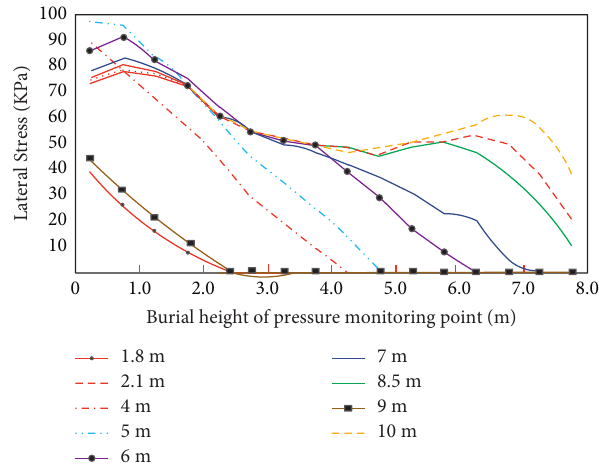
Figure 7: Curves of lateral stress-concrete heights.